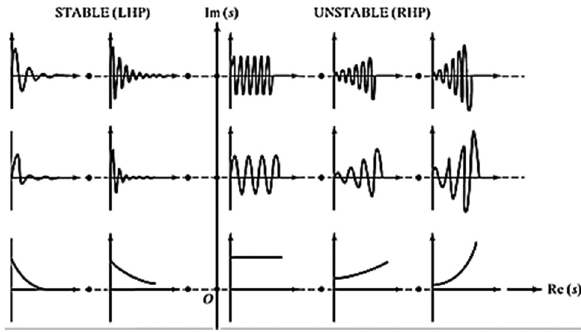
Figure 3: Locations of characteristic roots ( • ) and the corresponding responses of the system.